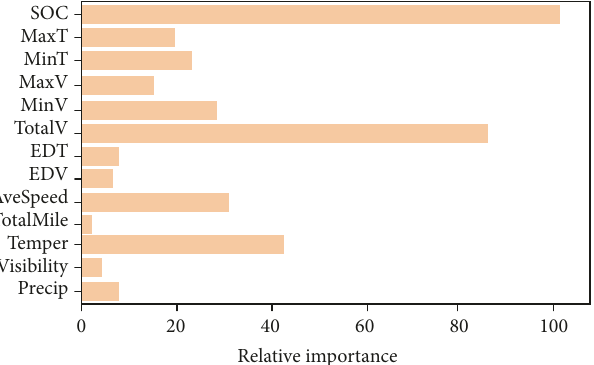
Figure 6: Relative importance of the